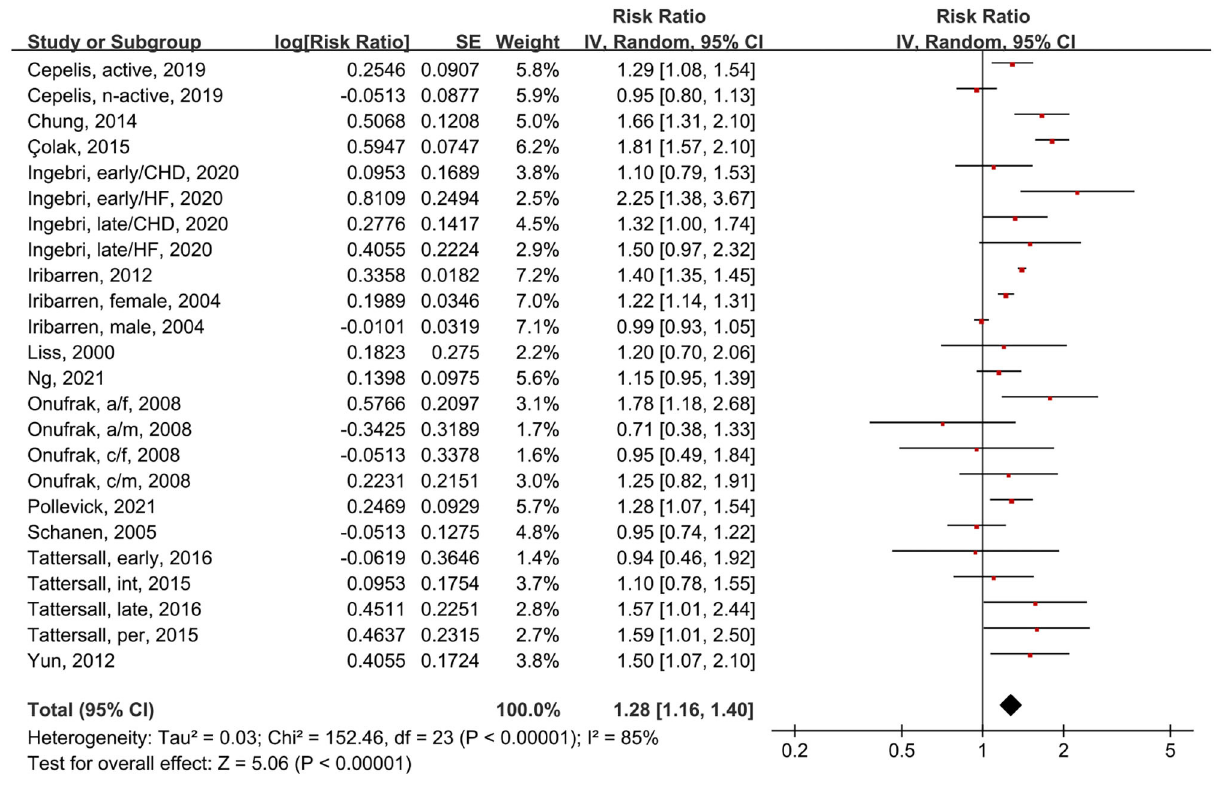
department visits for asthma within 12 months, whereas most